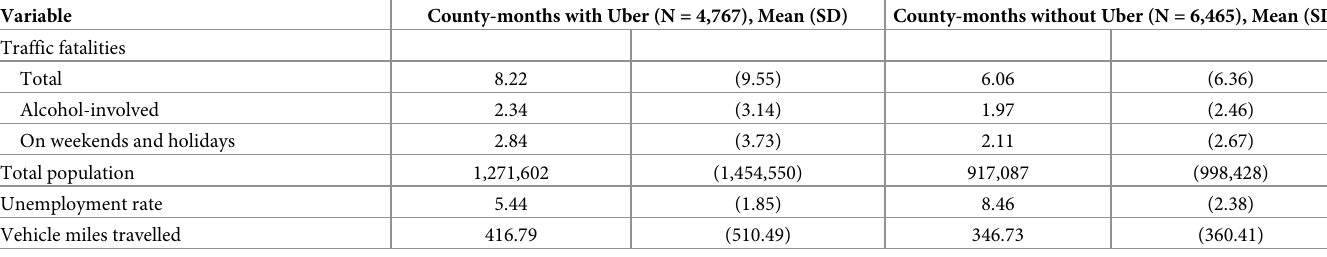
Table 1. Descriptive statistics for county-month sample, principal counties of the largest 100 US metropolitan areas, 2009–2017.